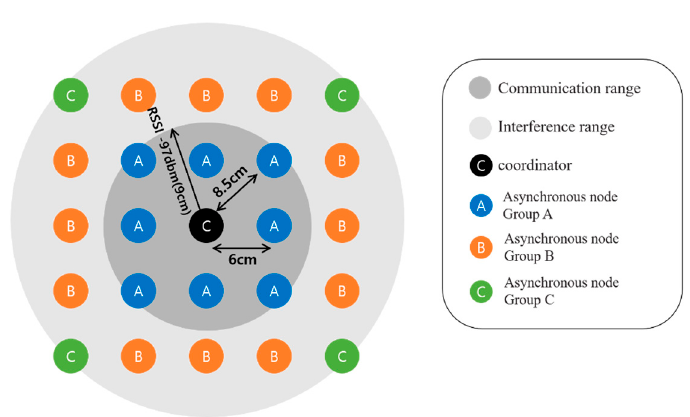
Figure 11. 5 × 5 Grid Mesh Topology.